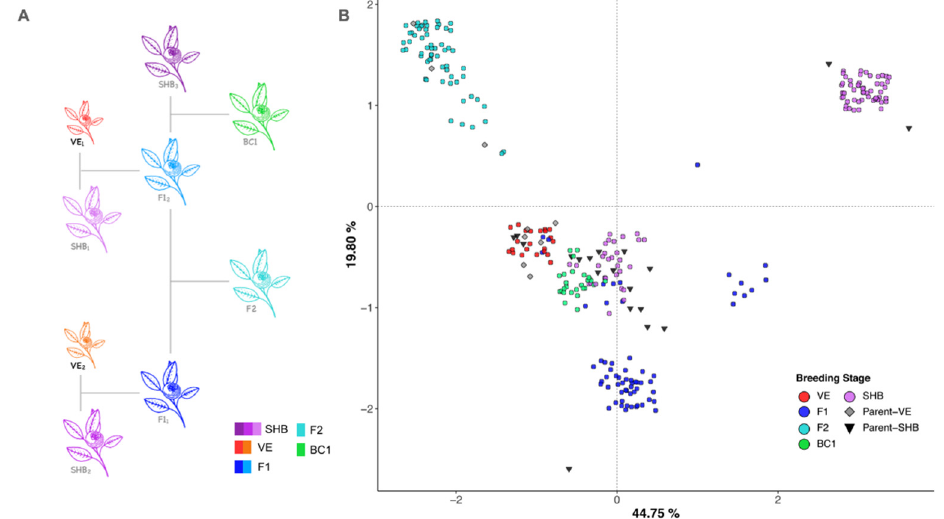
Figure 1. Description of the crosses and genetic variance observed for five stages of blueberry breeding. ( A ) Heredogram depicting how the families used in this study were obtained, V. elliottii introgressions are represented in smaller scale and ( B ) Percentage of the variance observed for the first and second principal components for the analysis of the relationship matrix considering the V. elliottii (VE), F 1 , F 2 , BC 1 , and Southern highbush (SHB) families. The Pedigree-based matrix was computed using the AGHmatrix package [24] considering Kerr et al. [25] methodology. Table 1. Genetic parameters and standard deviations estimated for nine fruit quality- and plant fitness-related traits.